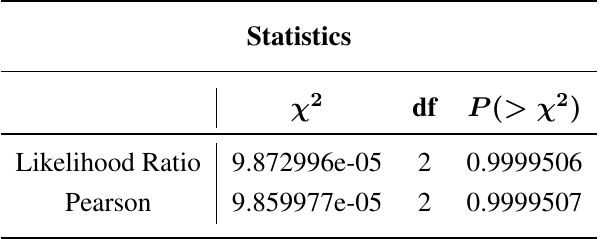
Table 8. Significance test of the null-hypothesis of conditional independence, referring to a log-linear model for dataset DFQR